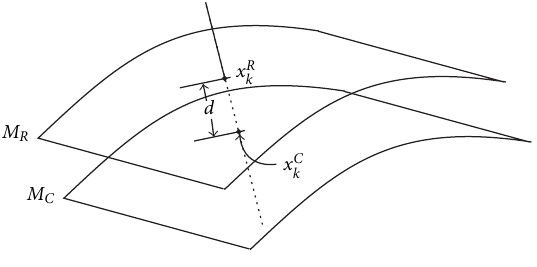
Figure 1: Distance between corresponding